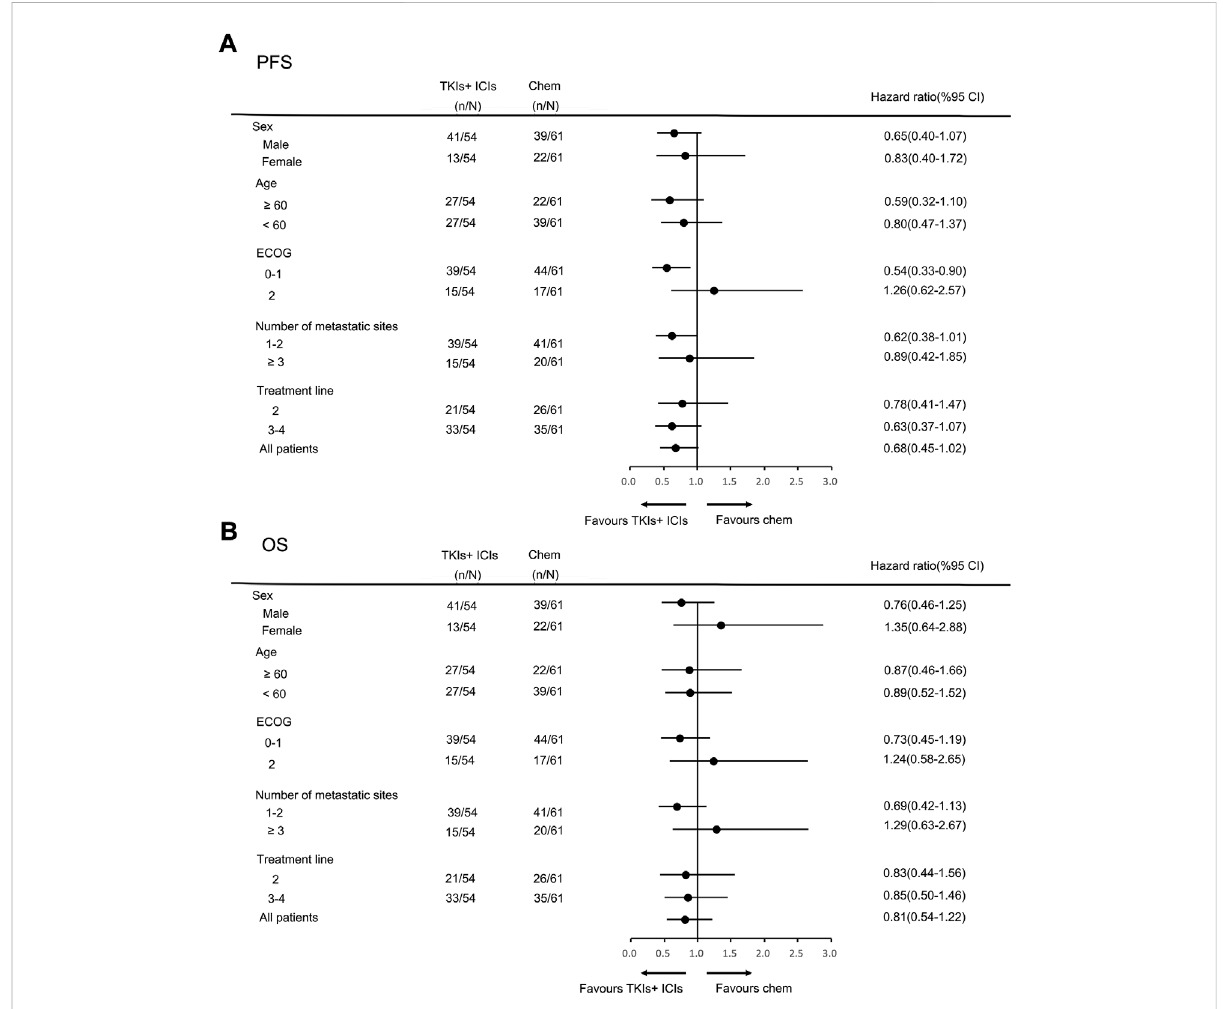
FIGURE 5 Subgroup analysis of PFS (A) and OS (B) according to clinicopathologic factors in TKIs + ICIs